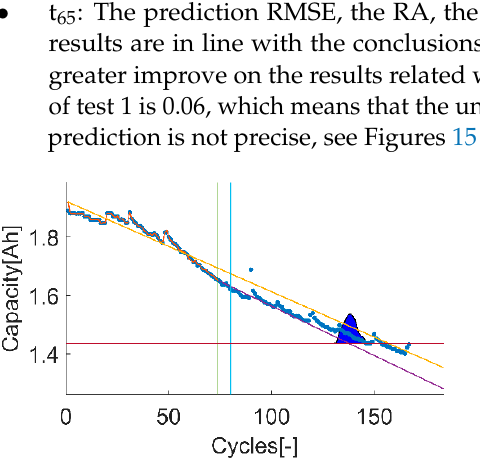
Figure 15. Time-instant figure of test 1 on t 65 .